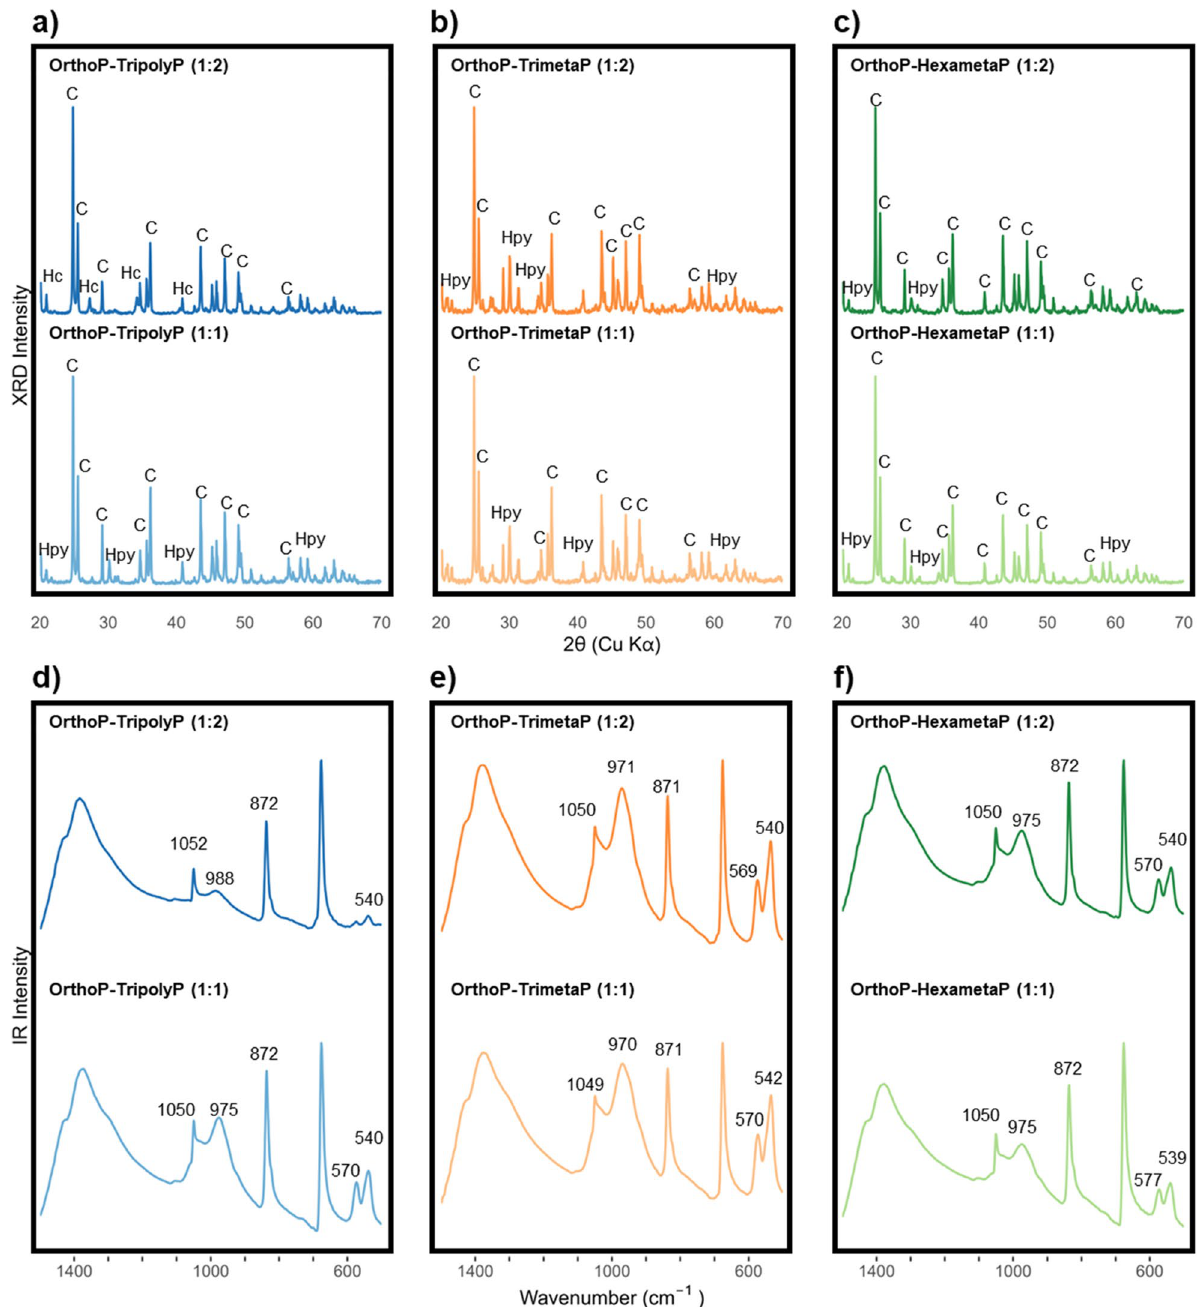
Figure 3. ( a – c ) XRD and ( d – f ) FTIR spectra of lead particles from CSTR experiments after reactions with orthophosphate-tripolyphosphate, orthophosphate-trimetaphosphate, and orthophosphate-hexametaphosphate at pH 7.5 and DIC 5 mg C L −1 . Prominent mineral or IR peaks are identified above. XRD lead mineral peaks are identified as follows: C—cerussite, Hc—hydrocerussite, and (weight %) as TripolyP was increased from 300 to 700 µg P L −1 (OrthoP-TripolyP at 1:1 and 1:2 ratios, respec- tively). Similarly, increasing the HexametaP concentration by the same mass (1:1–1:2) resulted in the disappear- ance of diffraction peaks characteristic of hydroxypyromorphite (2 θ = 22, 26.9, 30.5, 32.4, and 58.8°) (Fig. 3b, Fig. S3) and small rod-like crystals (Fig. 4f). This result was further supported by a decrease in the proportion of phosphorus on the lead solid from 13.79 ± 3.46 (1:1) to 0.24 ± 0.11 wt% (1:2). OrthoP-TrimetaP had minimal impact on lead release at both stagnation times (Fig. 2a,b). At a 1:1 ratio, median lead release in the presence of OrthoP-TrimetaP differed from OrthoP by just 2.0 and 9.3 µg Pb 0.45 µm m −2 whereas lead release at a 1:2 ratio was greater by just 1.9 and 28.0 µg Pb 0.45 µm m −2 at a 30-min HRT and 24HS, respectively. A 1:1 blend of OrthoP and TrimetaP decreased lead release at 24HS by 239.4 (209.8–269.1) and